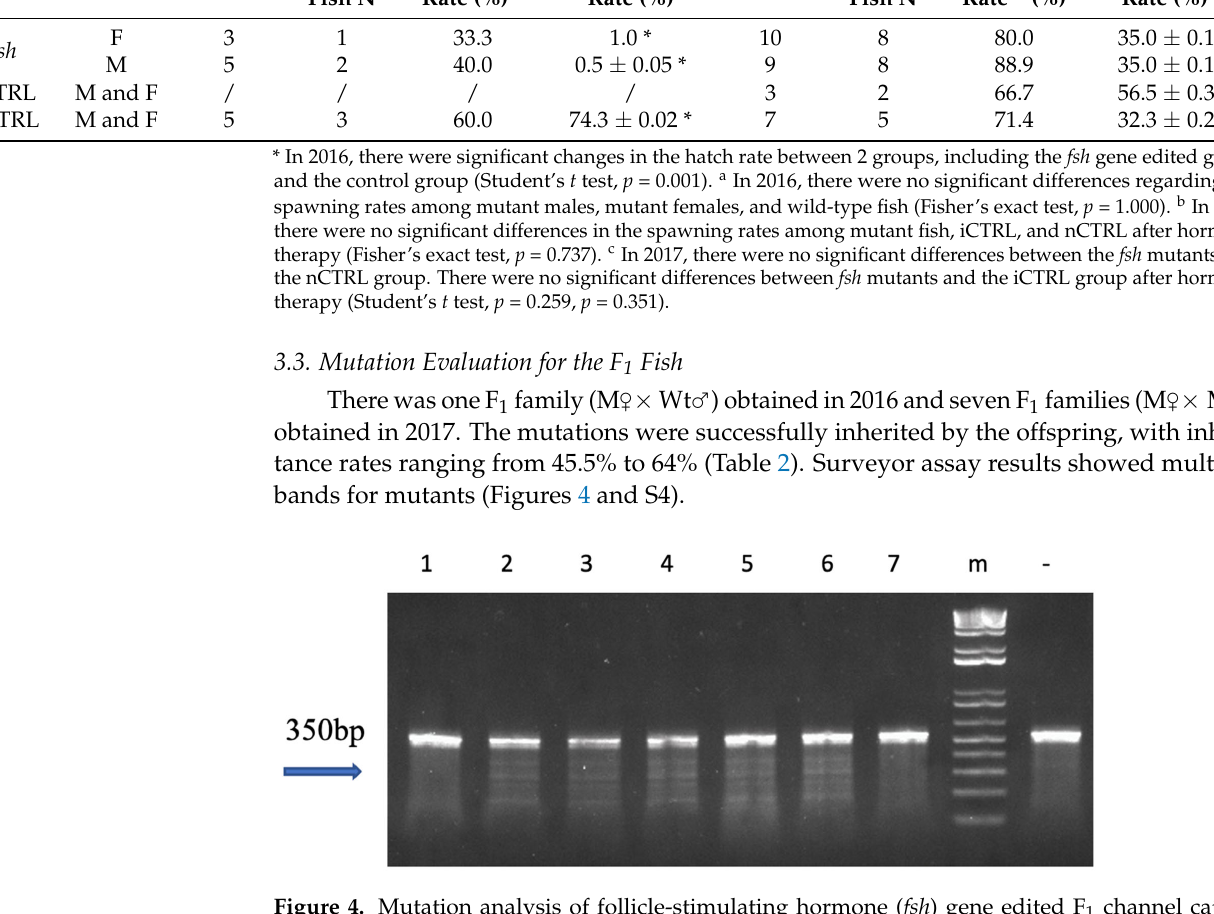
Table 1. Spawnability evaluation in terms of spawning rate and embryo hatch rate in two spawning seasons, 2016 and 2017. For the purpose of evaluating spawning, two different types of controls were used: the non-hormone-injected control (nCTRL) and the injected-hormone control (iCTRL) using a 90 µ g/kg luteinizing hormone releasing hormone analog (LHRHa) implant. In 2016, wild-type fish were coupled with 3 mutant females and 5 mutant males. The 90 µ g/kg LHRHa was only given to the wild-type female fish. In 2017, 10 female mutants were paired with 9 mutant males. A total of Table 2. Pleiotropic effects evaluation, including survival rate, mutation rate, and mean body weight of 1200 IU human chorionic gonadotropin (HCG) was given to both females and males. To calculate the channel catfish ( Ictalurus punctatus ). There are a total of 8 families of F 1 progeny, including one 1.5 ‐ year ‐ hatch rate, divide the number of eggs hatched by the number of eggs in total, then multiply by 100. old 2016 FSH family without performing hormone therapy and seven 1 ‐ year ‐ old 2017 FSH families with hormone therapy (2017 FSH ‐ 1, FSH ‐ 2, FSH ‐ 3, FSH ‐ 4, FSH ‐ 5, FSH ‐ 6, and FSH ‐ 7). The 2016 FSH family Mean hatch rate data were displayed as the mean of all families ± standard error (SEM). was generated from one fsh ‐ mutated female fish paired with wild ‐ type channel catfish without hormone treatment. However, 2017 FSH families were generated from mutant females mated with mutant males with hormone therapy. The 2017 FSH ‐ 5 family of fish perished as a result of low dissolved oxygen. Data on body weight are displayed as the mean of the body weight ± standard error (SEM).